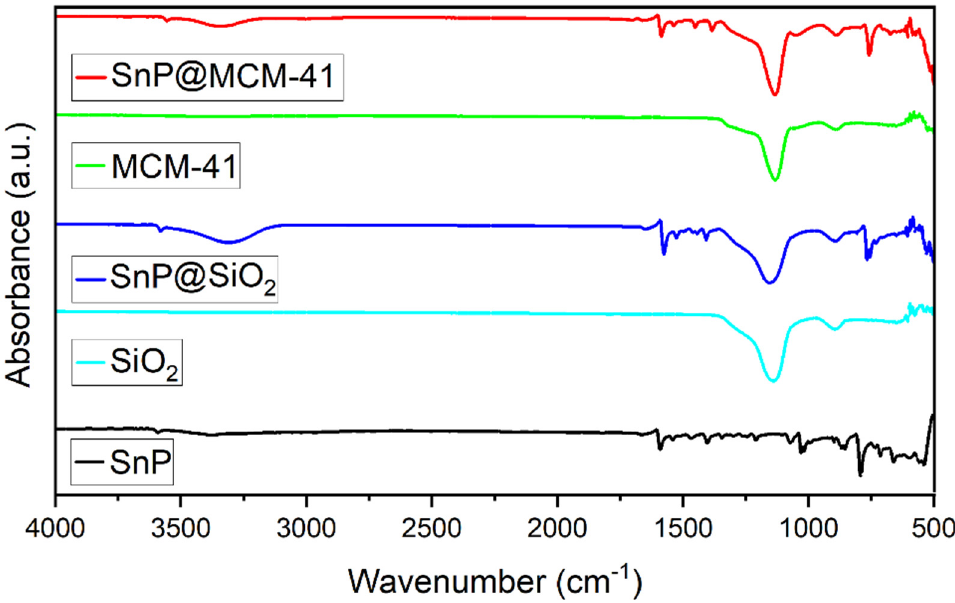
Figure 1. FTIR spectra of SnP , SiO 2 , SnP@SiO 2 , MCM − 41, and SnP@MCM − 41 .